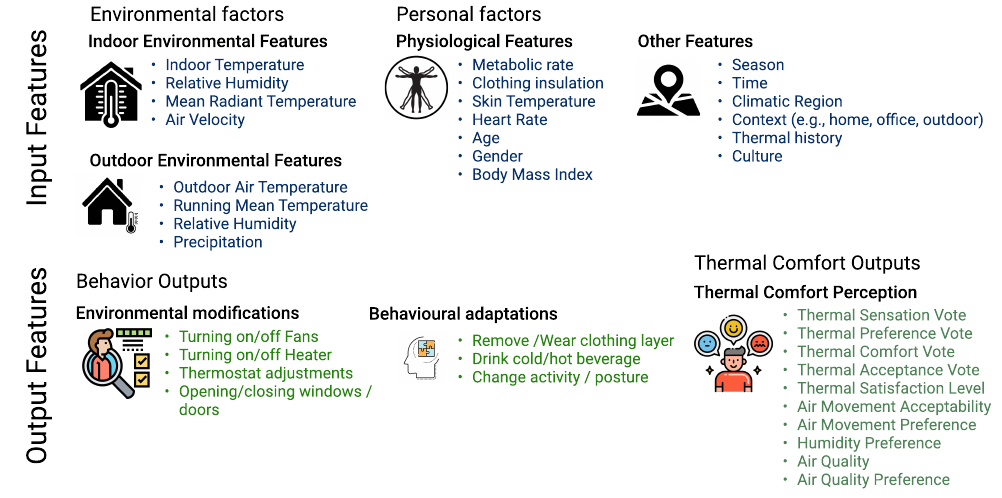
Figure 1. Subjective Input and Outputs for Thermal